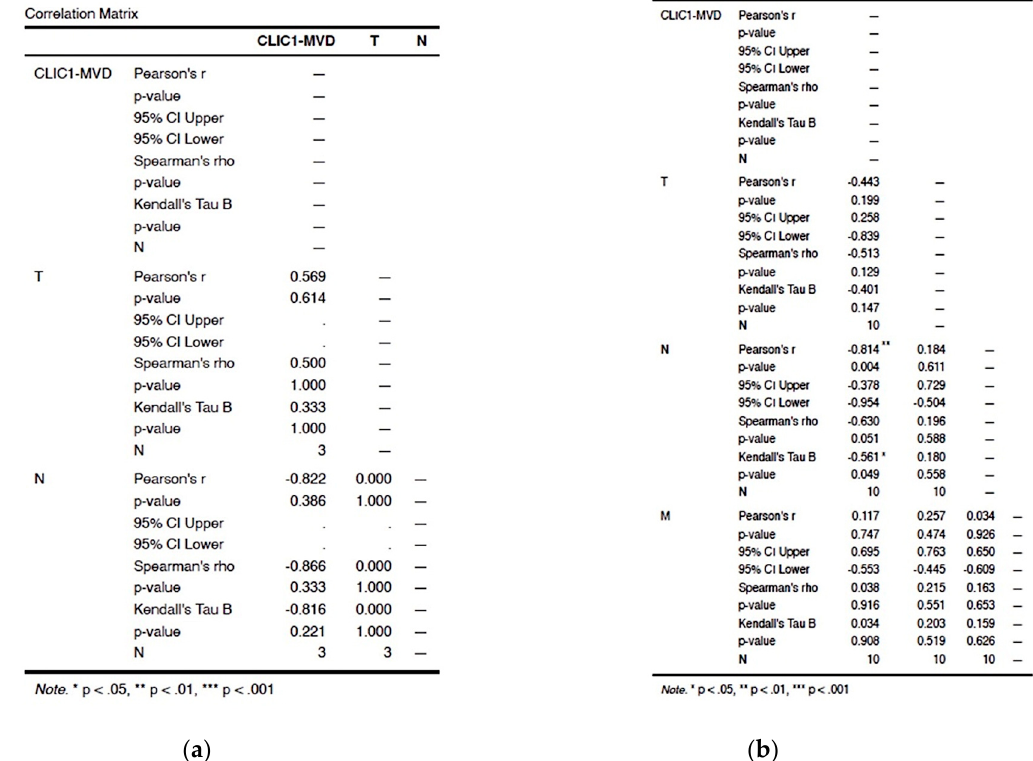
Figure 2. Correlation matrix from statistical analysis applied for Class 1 ( a ) and Class 2 ( b ) ccRCC subgroups related to CLIC1 expression in tumor blood vessels (CLIC1-MVD). Note the lack of significant correlation for Class 1 ( a ) and the significant correlation between CLIC1-MVD and nodal status N from TNM staging for Class 2 of